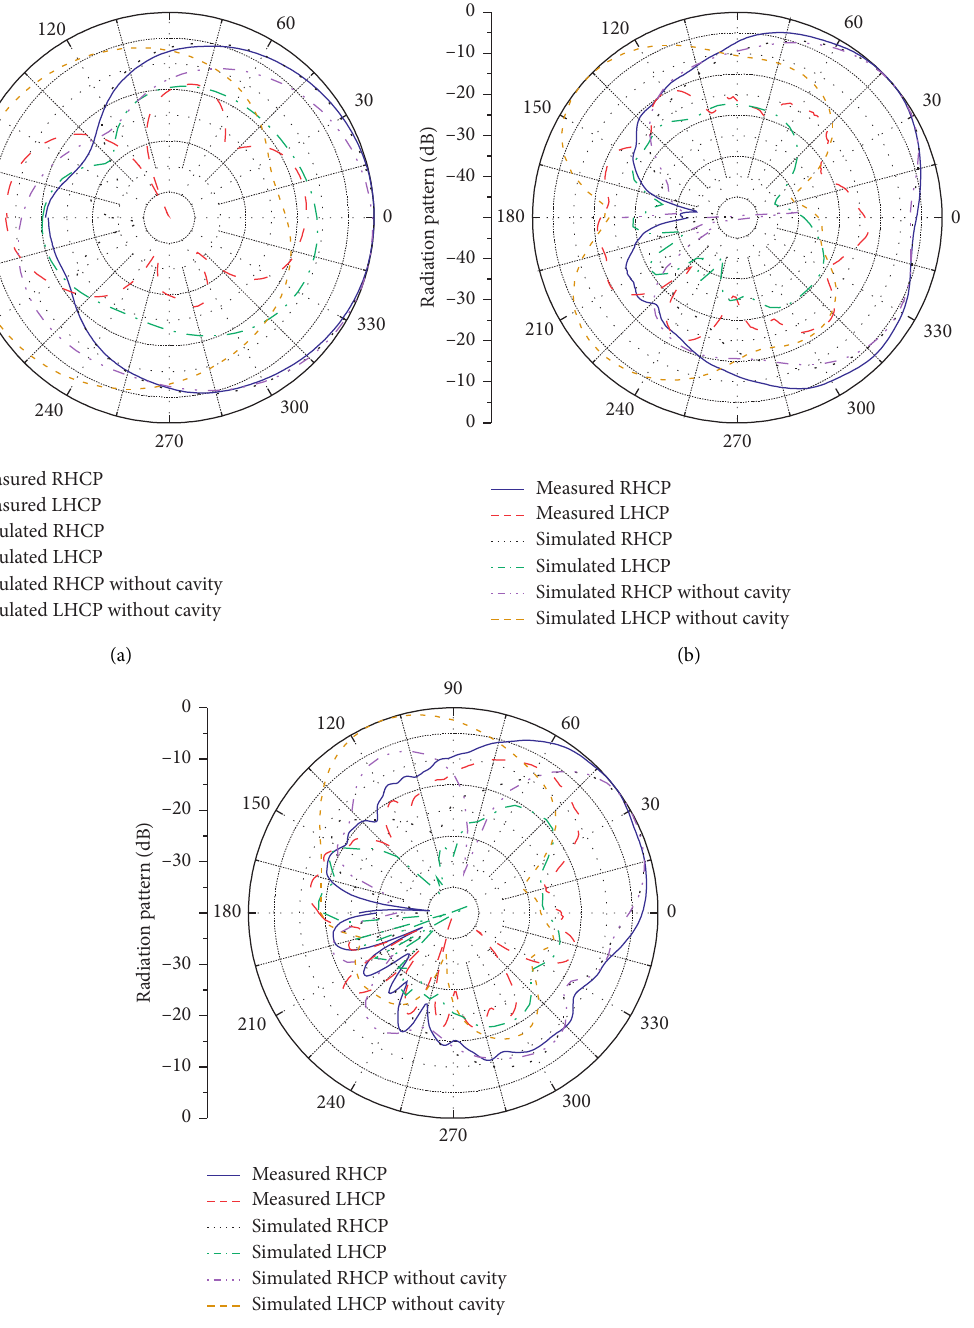
Figure 23: Measured and simulated normalized radiation patterns at different frequencies. (a) 1GHz. (b) 4 GHz. (c)